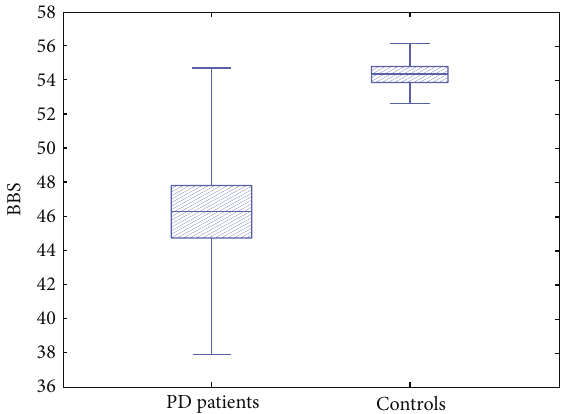
Figure 1: Berg Balance Scale values in PD patients compared to controls. As expected, BBS values were lower in PD patients compared to controls.